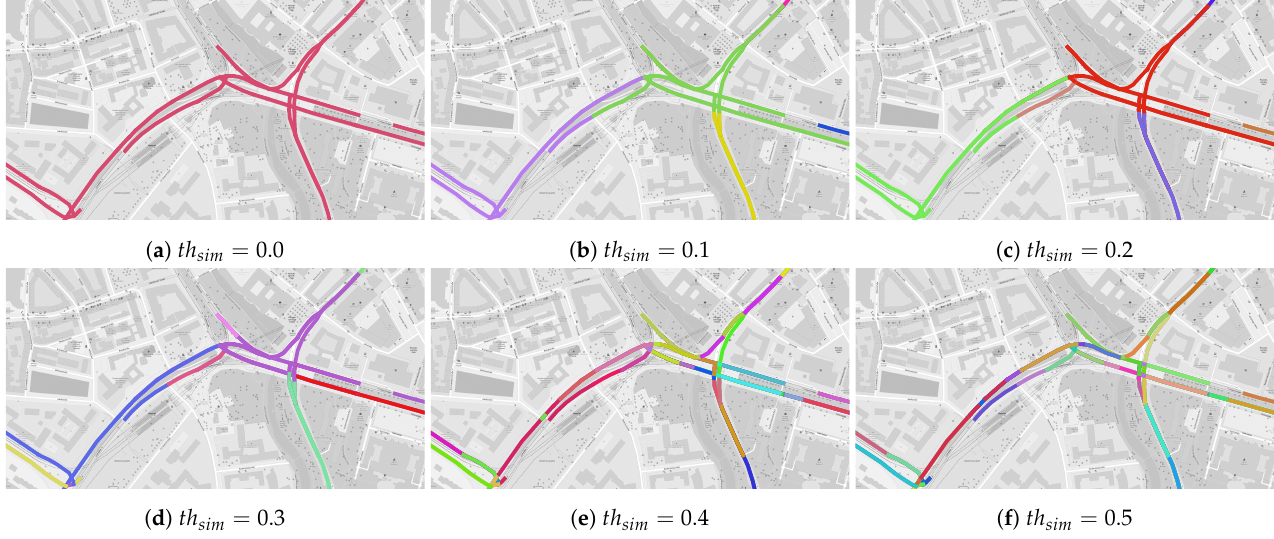
Figure 10. Example of affected subgraphs calculated for a major junction in Hanover with varying values of th sim . Colours of the road segments indicate the subgraph assignment of the segments. Map images: c (cid:13) OpenStreetMap contributors,